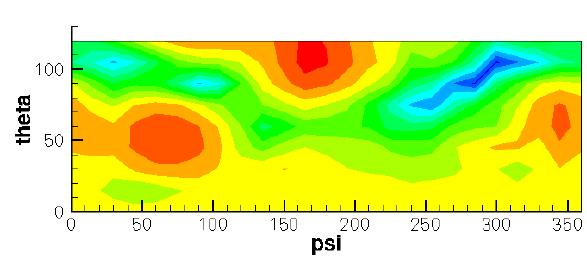
Figure 8: Two-dimensional representation of OASPL evaluated on the hemisphere surface by Technique A at point 1 in maneuver ID8021.